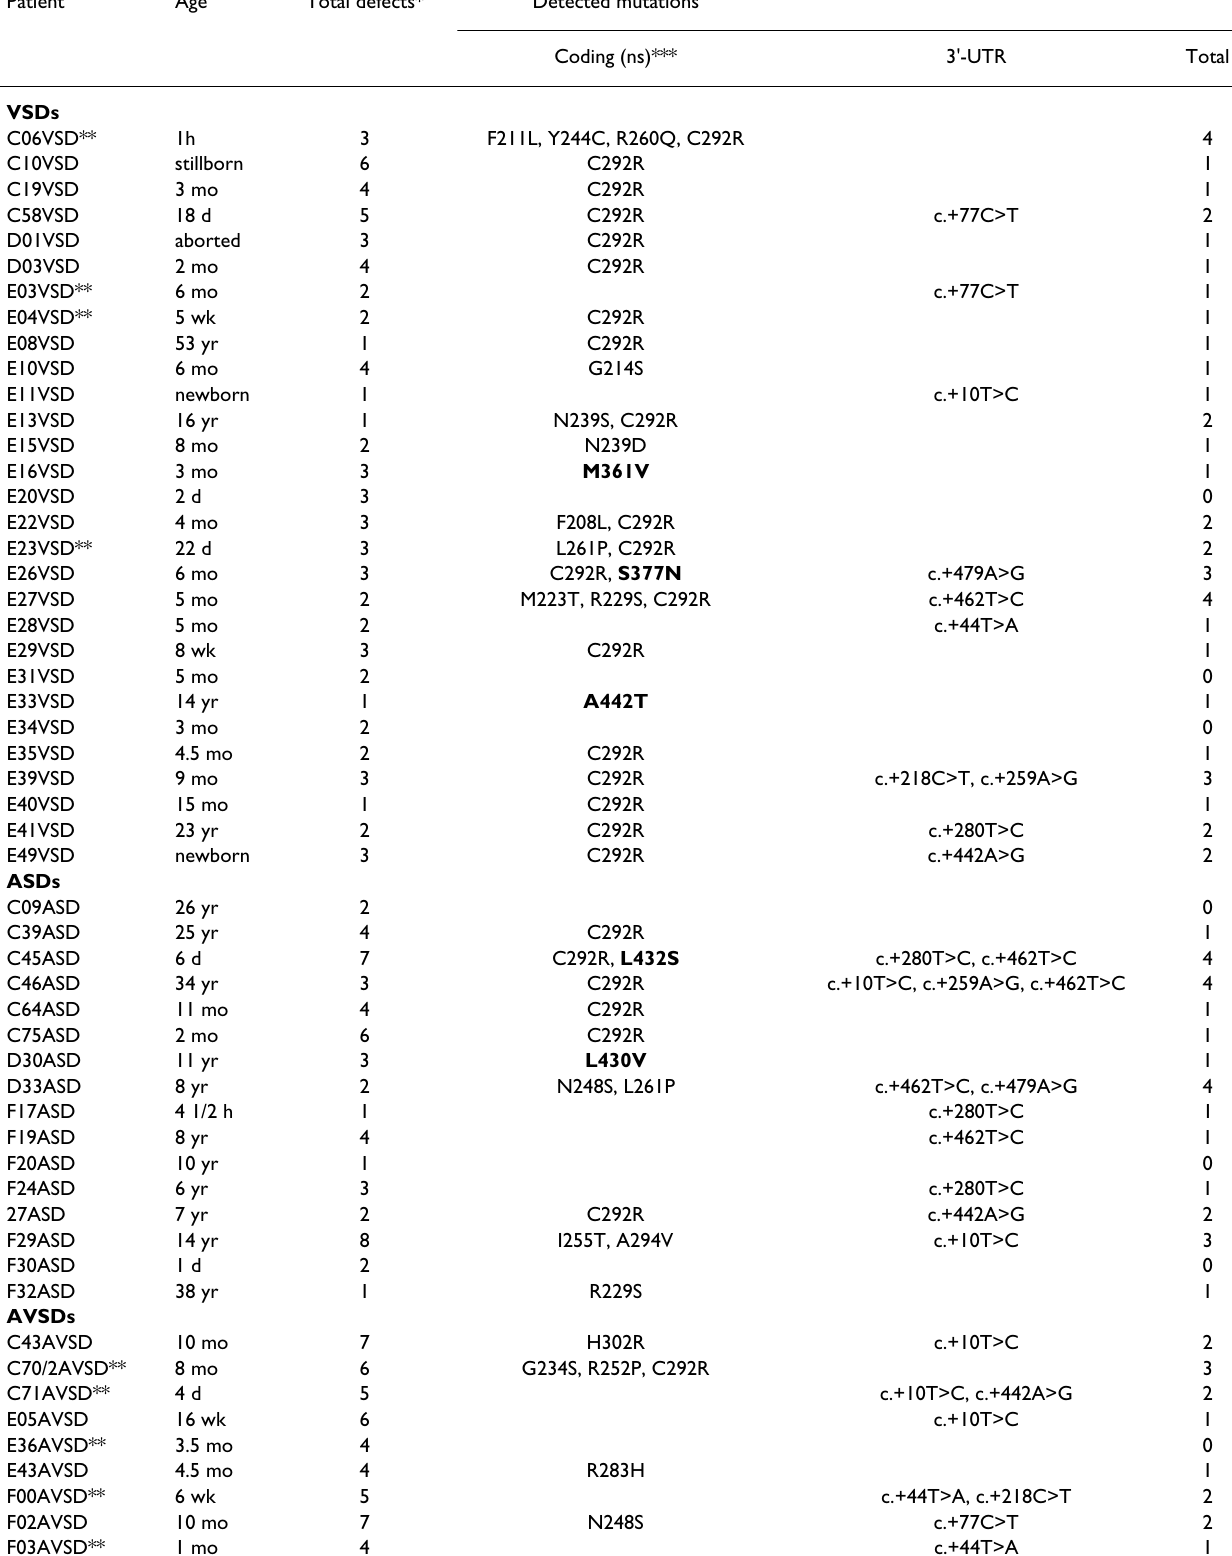
Table 3: Spectrum of GATA4 mutations (nonsynonymous and 3'-UTR) in diseased tissues of malformed hearts Patient Age Total defects* Detected mutations Coding (ns)*** 3'-UTR